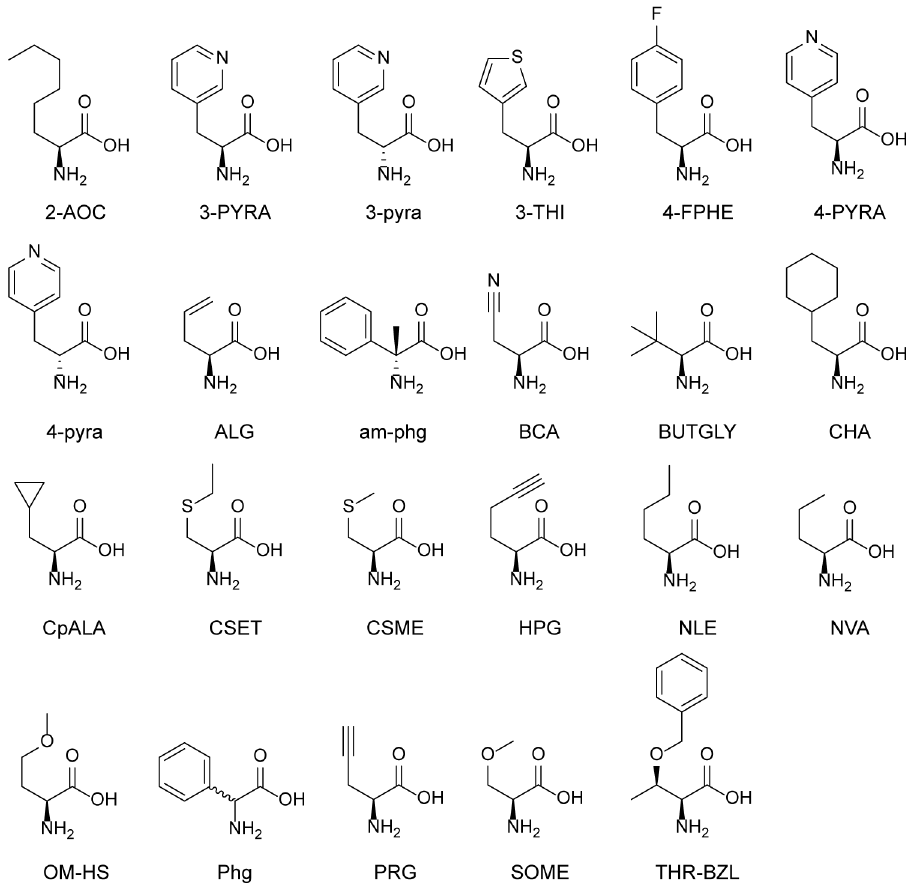
Fig 1. Structures of non-proteogenic amino acids found in the best CPLs. L-amino acids are denoted in uppercase characters; D-amino acids in lowercase characters. Incorporation of Phg results in a racemic